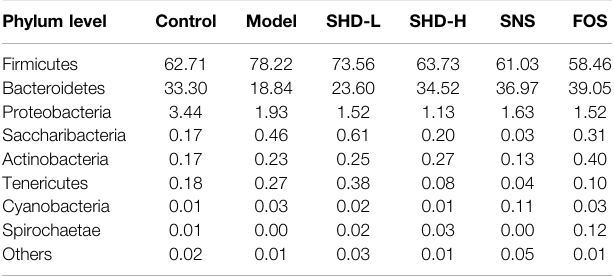
TABLE 2| Effect ofSHDon bacterial abundance(byphylum)ineach group ofrats (%, n (cid:2) 7 – 8) Phylum level Control